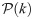
Inference on the birth-death model.A: Histogram of the posterior P(k) estimate obtained with LF-NS using N = 100 and H = 100. The true posterior is indicated in black. B: Development of the estimation of the Bayesian evidence using the estimation based solely on the dead points Z^D, the estimate approximation from the live points Z^L and the estimation based on both Z^tot. The corresponding standard errors are indicated as the shaded areas. The true Bayesian evidence is indicated with the dashed red line. C: Estimate of the current variance estimate σ^tot2m and the lower bounds for the lowest achievable variance σ^min2. D: Developments of the different error estimations for each iteration.